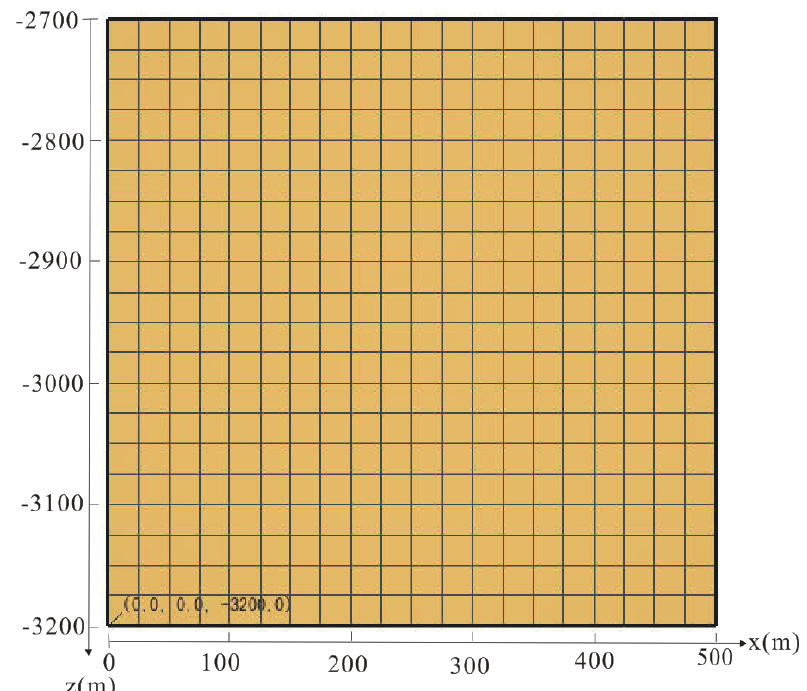
Figure 4. The simulated domain and two-dimensional grid for the horizontal well system.